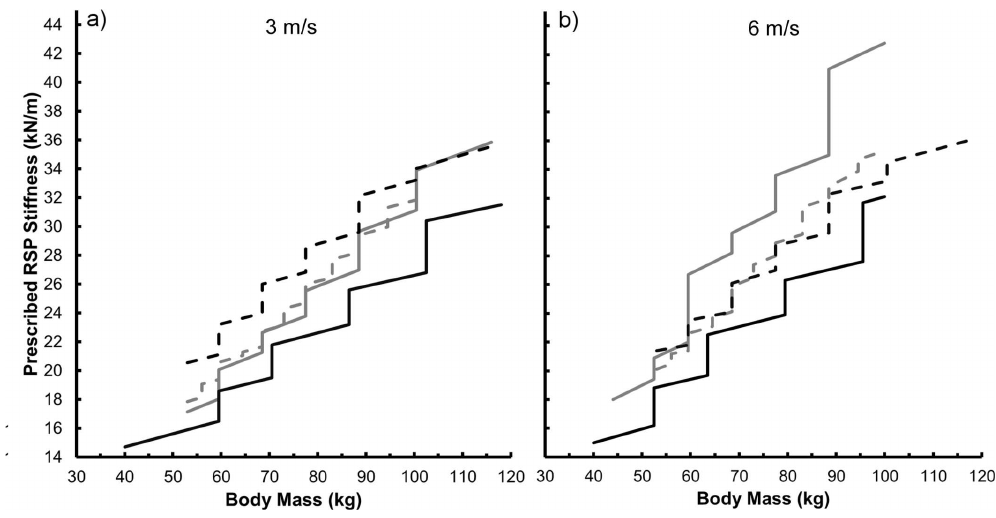
Fig 4. Prescribedprosthetic stiffness. The averagestiffness (kN/m) of each running-specific prosthesis(RSP) as a function of the respective manufacturer’s recommended user body mass (kg) at runningspeeds of 3 m/s (a), and 6 m/s (b). The stiffness of each RSP was calculatedusing peak applied force magnitudes that simulated running3 m/s ( α 3 and β 3 ) and 6 m/s ( α 6 and β 6 ). We then calculateddisplacement using the mean curvilinear force- displacement profileswith the appropriate appliedforce magnitudes. See S1–S4Tables.